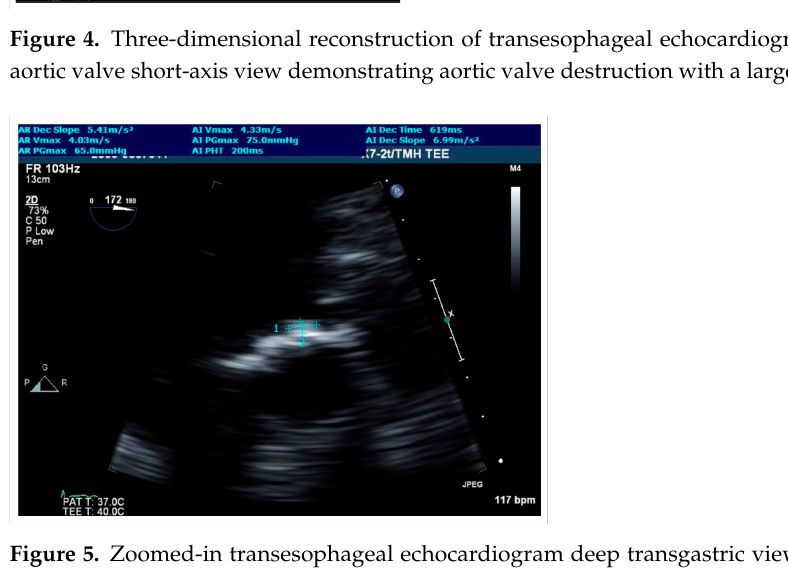
Figure 5. Zoomed-in transesophageal echocardiogram deep transgastric view of the aortic valve from the left ventricular outflow tract. Cross-hairs depict the mass on the aortic